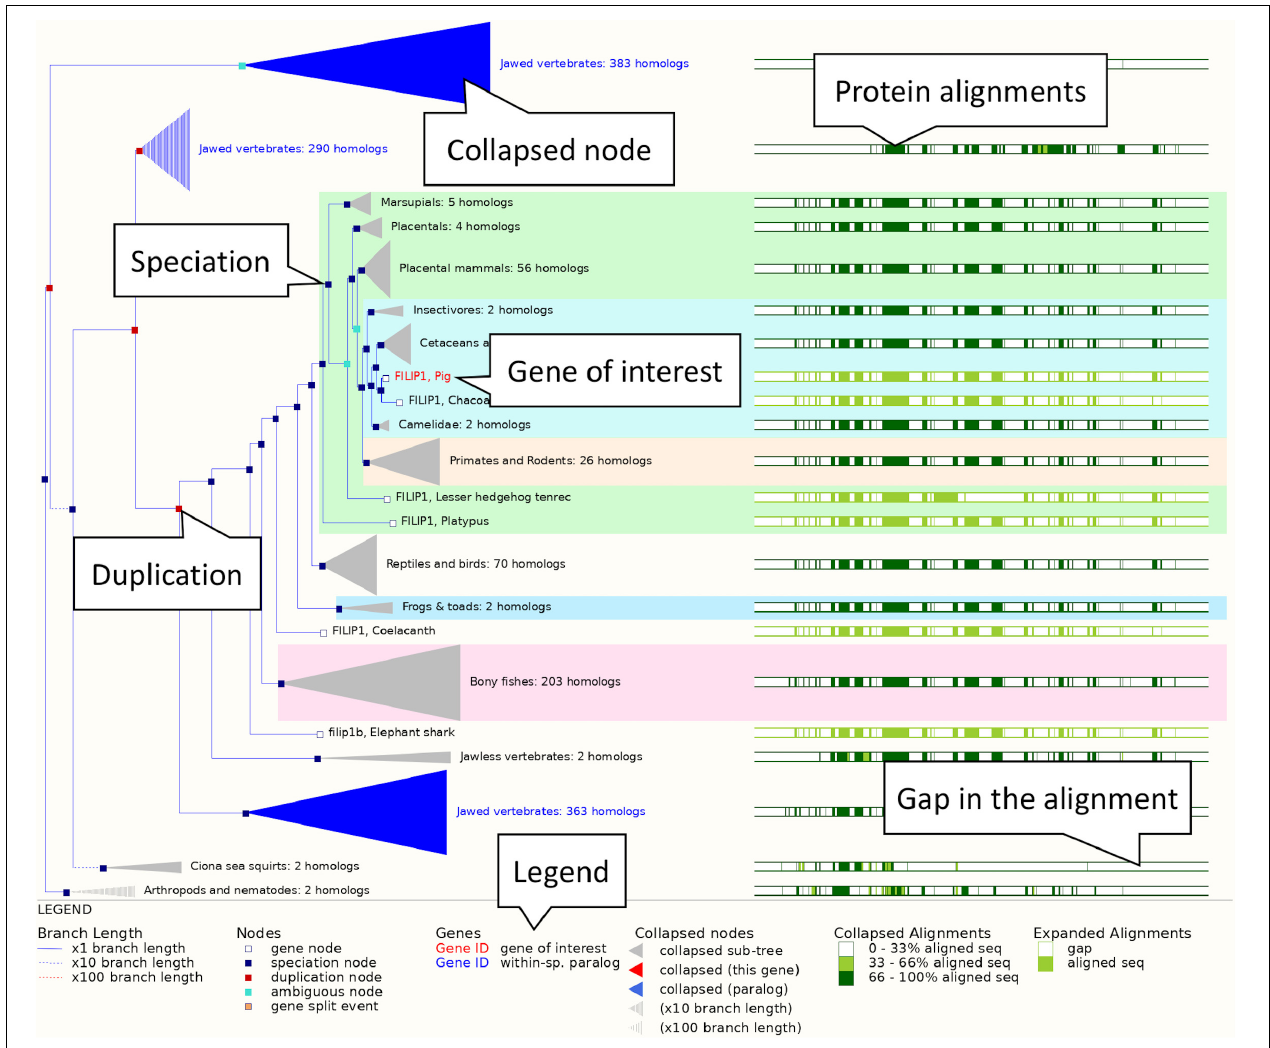
FIGURE 3 | The FILIP1 gene tree. The pig FILIP1 gene is highlighted in red. Various other clades are collapsed into funnels to improve usability of the tree. Subtrees can be expanded and collapsed by clicking on the corresponding node (represented by a square on the tree) and selecting the appropriate option from the menu. The right-hand side shows a visual representation of alignment conservation of the corresponding protein sequences across the